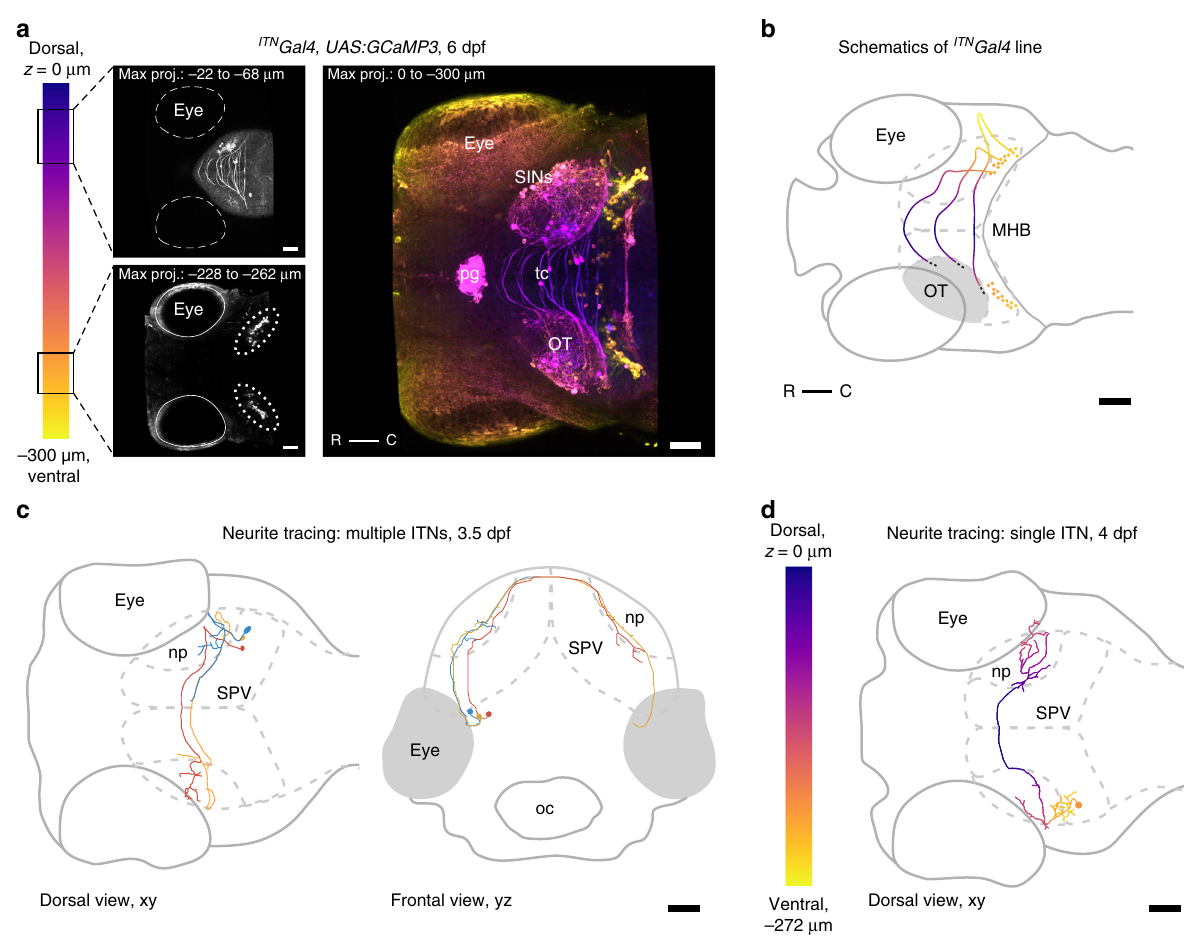
Fig. 2 Intertectal neurons connect the two hemispheres of the optic tectum. a Maximum intensity projections of an ITN Gal4 transgenic larva viewed dorsally at 6 dpf in which neurons that connect the two hemispheres of the optic tectum (intertectal neurons, ITNs) are labeled (most dorsal plane through the larva is indicated by z = 0 µ m). The cell bodies of ITNs are situated in two bilateral symmetric nuclei below the respective tectal lobes (ITN nuclei highlighted by dotted ellipses in lower left panel) and send their axons dorsally through the tectum crossing the tectal commissure in ladder-like trajectories (upper left panel). In addition to labeling ITNs in the mesencephalic tegmentum, Gal4 is also expressed in the pineal gland, SINs, scattered periventricular neurons (PVNs), and the spinal cord in this transgenic line. All scale bars = 50 μ m. (pg: pineal gland, tc: tectal commissure, OT: optic tectum, R: rostral, C: caudal, SINs: super fi cial interneurons). b Schematic of the transgenic ITN Gal4 line depicted in a . ITN cell bodies and axon tracts are color-coded according to the position in the dorsoventral z -plane. To increase readability only the right ITN ’ s connectivity with respect to the larva is shown. Scale bar = 50 μ m. (MHB: midbrain-hindbrain boundary, OT: optic tectum, R: rostral, C: caudal). c Neurite tracing of multiple ITNs in a larva at 3.5 dpf. At 3.5 dpf ITN neurites start to cross the midline (e.g., the blue ITN). In addition, ITNs begin to form arbors at the boundaries between the deep layers of the neuropil and the PVN layer. Scale bar = 50 μ m. (oc: mouth/oral cavity, np: tectal neuropil, SPV: stratum periventriculare ). Color-coded to simplify distinction between single ITNs. d Neurite tracing of a representative ITN at 4 dpf, color-coded according to the position in the dorsoventral z -plane (most dorsal plane of the larva is indicated by z = 0 µ m). ITN axons cross the midline super fi cially and form arborization patterns of increasing complexity in